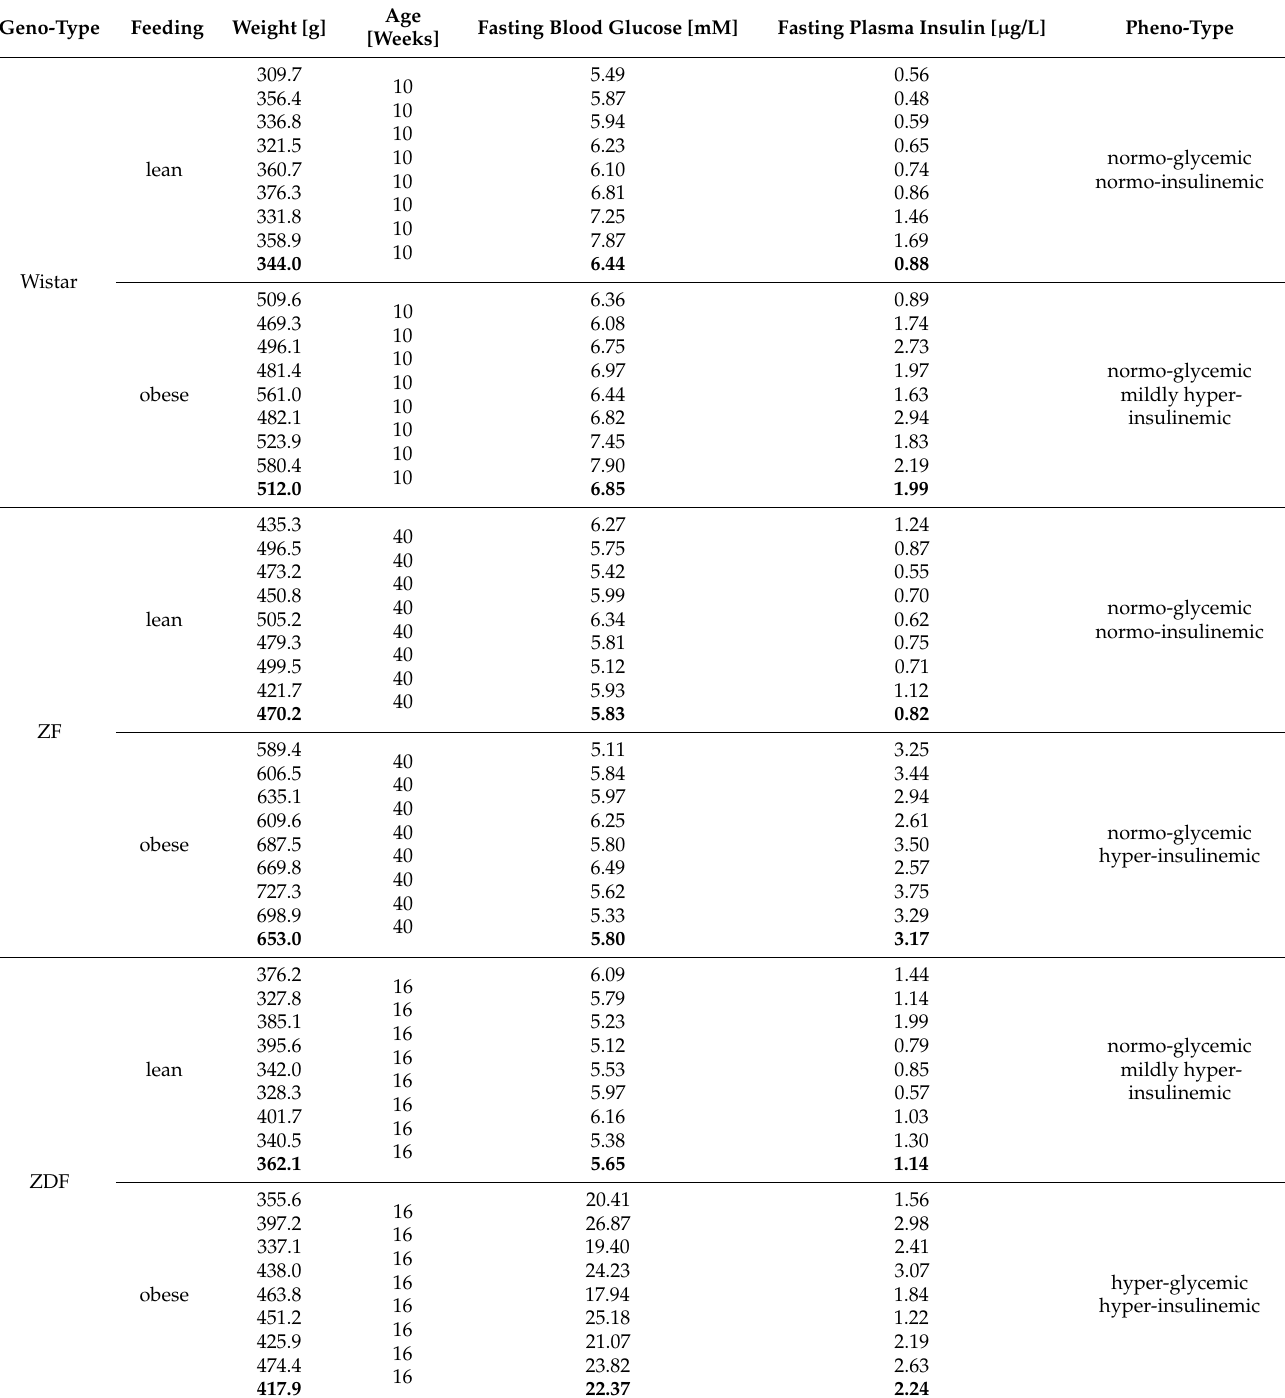
Table 1. Characteristics of the rats. Mean values of weight, fasting blood glucose, and fasting plasma insulin for each rat group (of given genotype and feeding) are given in